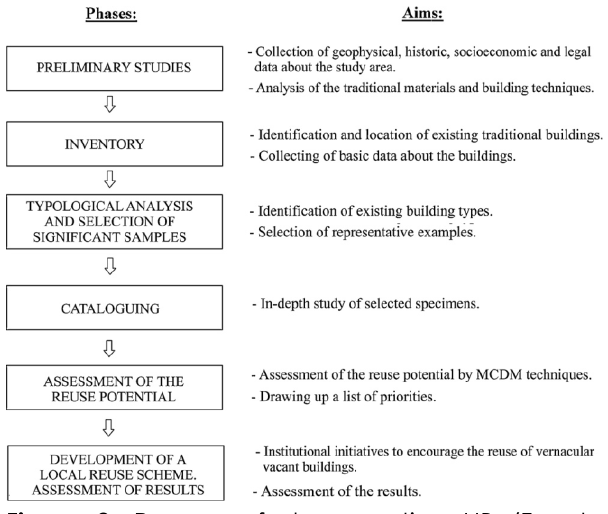
Figure 2. Process of documenting HB (Fuentes,